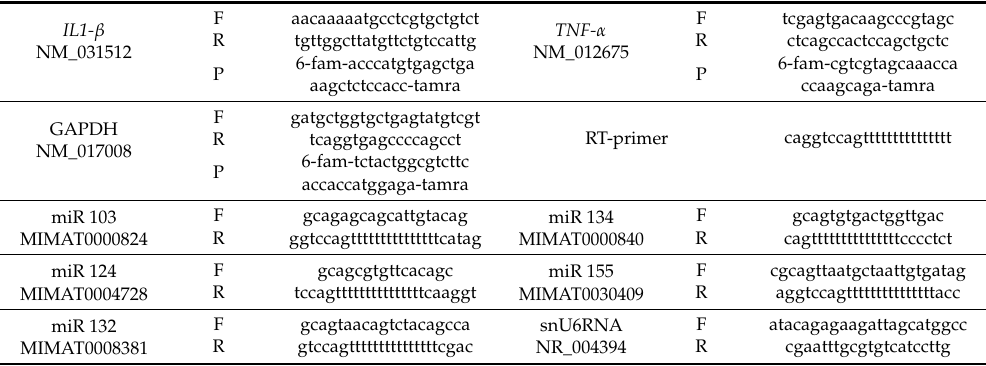
Table 1. Primer and probe sequences for messenger RNA (mRNA) and microRNA (miRNA) analyses. All primers and probes were synthesized from metabion. F: forward primer, R: reverse primer, P: probe, RT: reverse